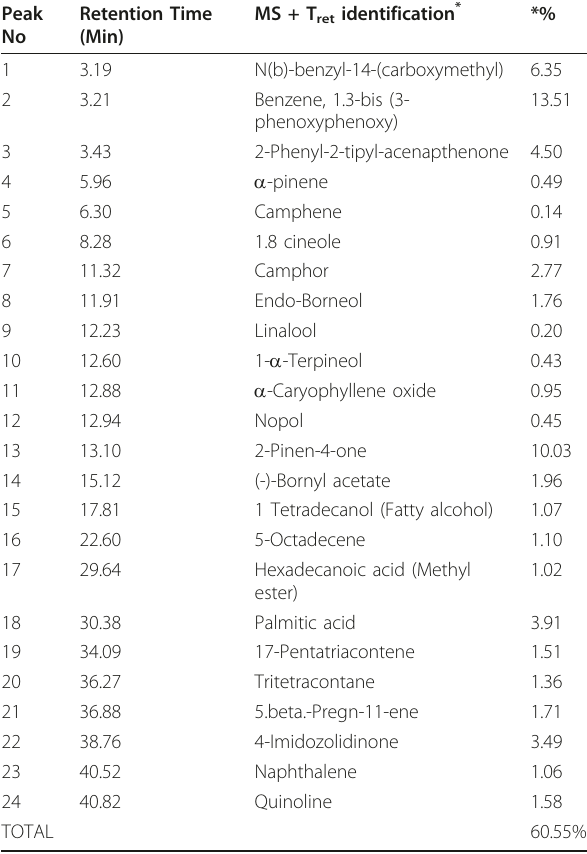
Table 1 The phytochemicals of the n -Hexane fractions from acetone extracts of Bridelia micrantha Peak Retention Time No